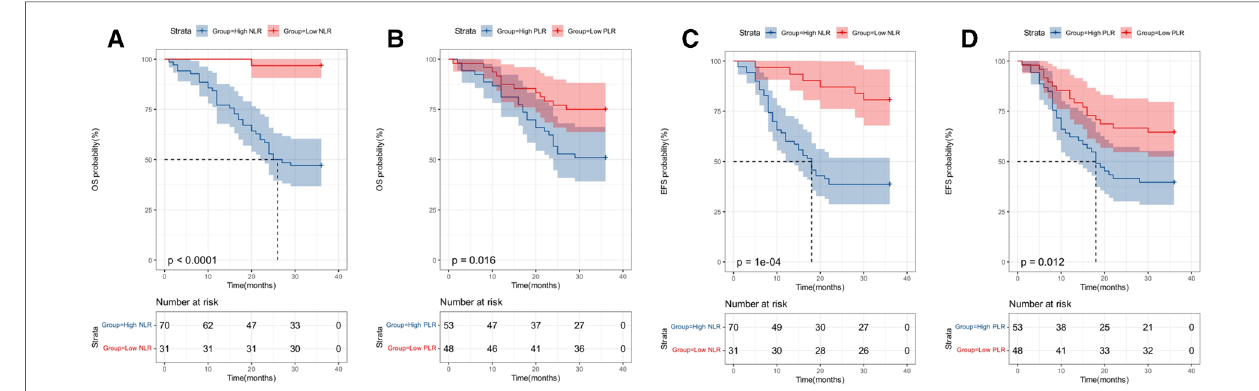
FIGURE 2 Survival analysis. ( A ) Kaplan – Meier survival curves of overall survival according to neutrophil-to-lymphocyte ratio (NLR). ( B ) Kaplan – Meier survival curves of overall survival according to platelet-to-lymphocyte ratio (PLR). ( C ) Kaplan – Meier survival curves of event-free survival according to neutrophil-to-